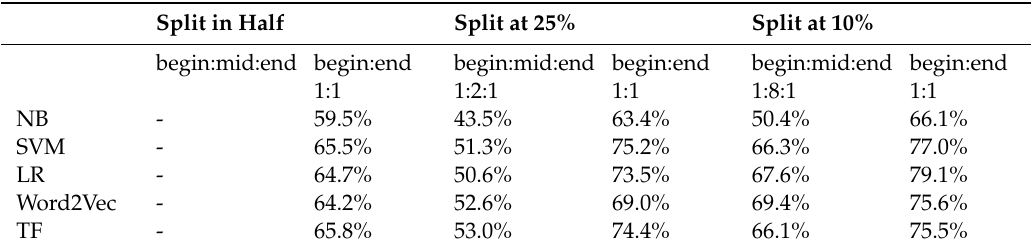
Table 6. Mean accuracy of classifiers for di ff erent splits—Western